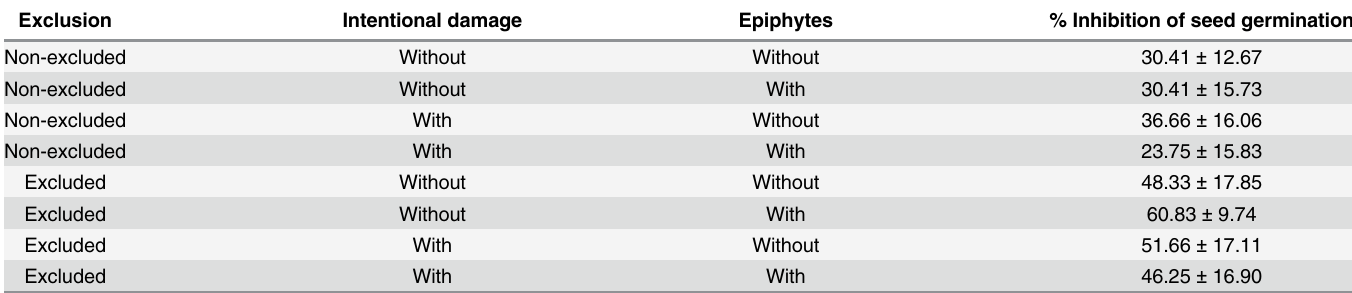
Table 3. Percentage of inhibition of the germination (mean ± SE) of T . recurvata seeds in response to the application of dichloromethane extracts obtained from branches of I . murucoides . The data shown correspond to the triple interaction of the three main factors of the experiment: exclusion (excluded vs . non-excluded branches), intentional damage (branches with intentional damage vs . branches without intentional damage) and with the pres- ence/absence of T . recurvata (N = 24).